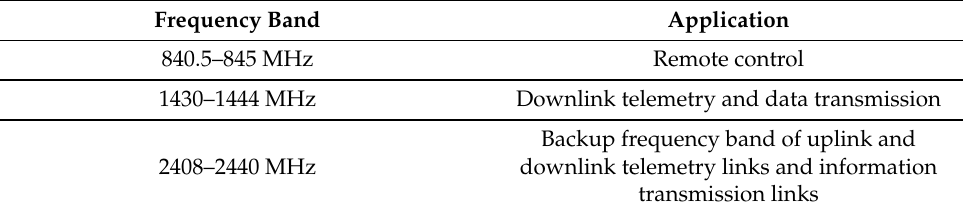
Table 3. Spectrum allocation of UAV (China)